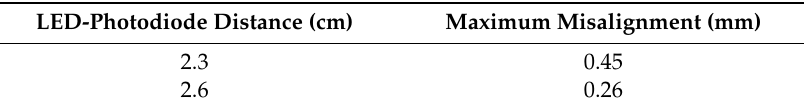
Table 2. Misalignment tests